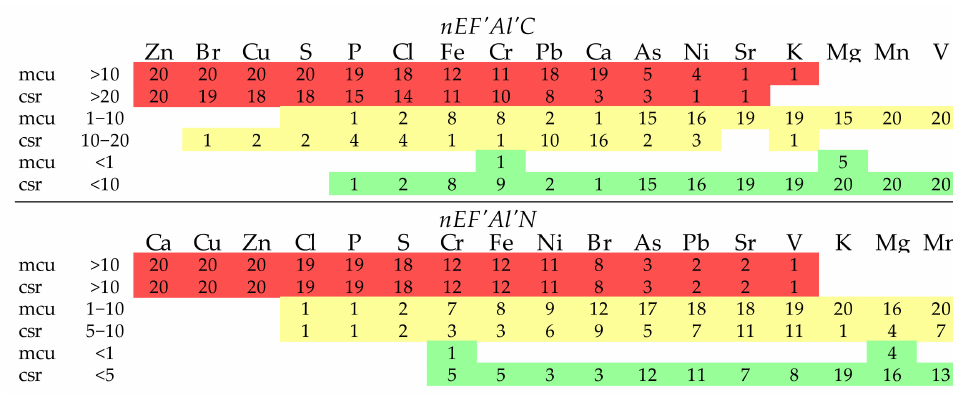
Figure 15. The frequency of elemental nEF’Al’C and nEF’Al’N values of twenty TSP sampling sites in three levels indicating possible origin of emission source of analytes. Explanation: mcu are intervals when the thresholds are selected taking into account common publications [45–47], crs are those when thresholds suggested in [40] are selected. The red color shows the intervals where the presumable origin of analytes is anthropogenic, green color when it is crustal, while yellow color when it is